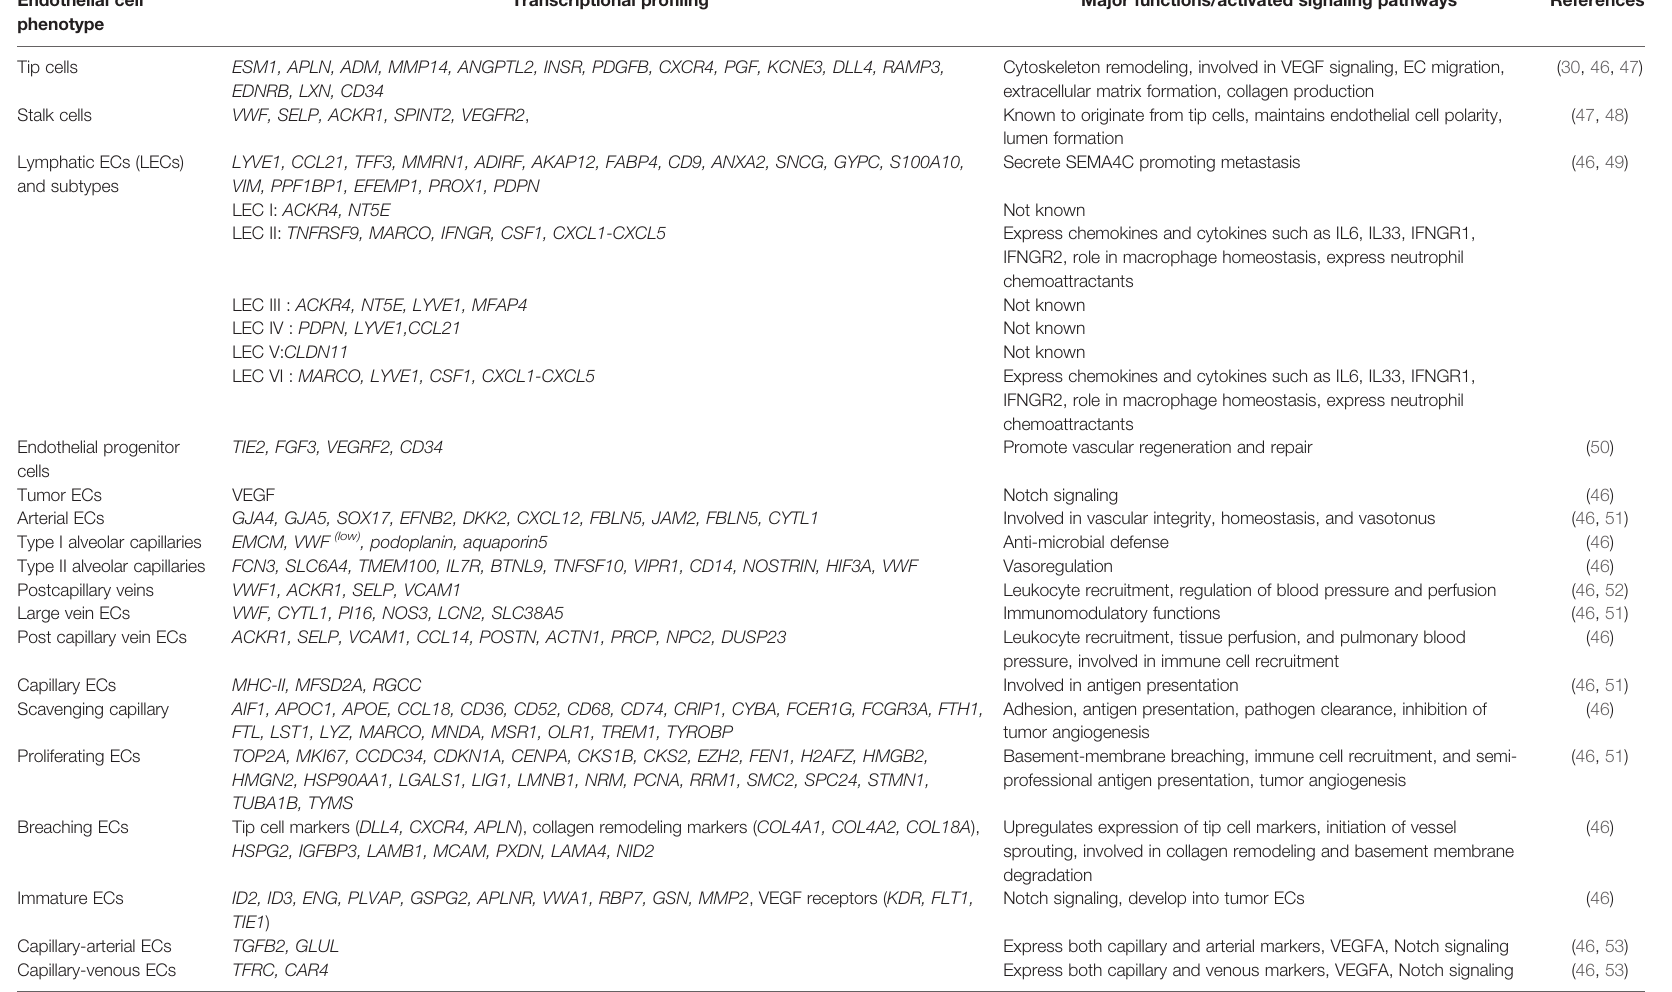
TABLE 2 | Molecular pro fi ling of endothelial cell heterogeneity in tumor human/mouse tissue